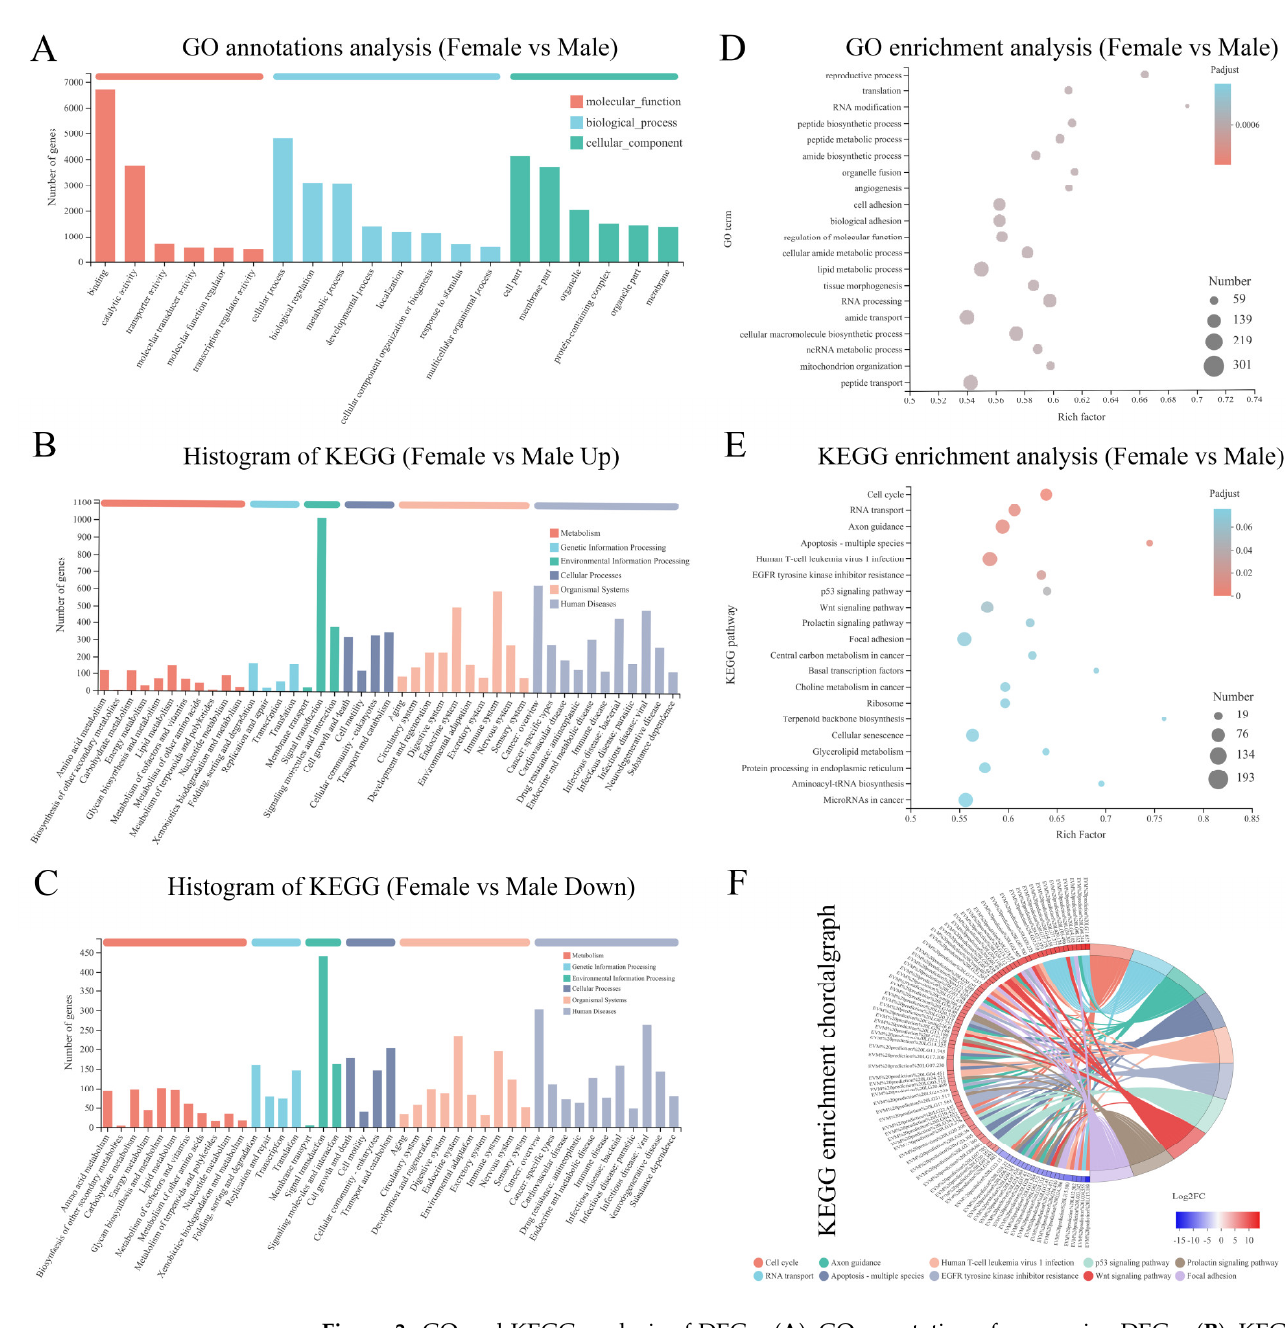
Figure 3. GO and KEGG analysis of DEGs. ( A ): GO annotation of responsive DEGs. ( B ): KEGG annotation of responsive DEGs (Up). ( C ): KEGG annotation of responsive DEGs (Down). ( D ): GO enrichment analysis. ( E ): KEGG enrichment analysis. (F): KEGG enrichment chordal graph.